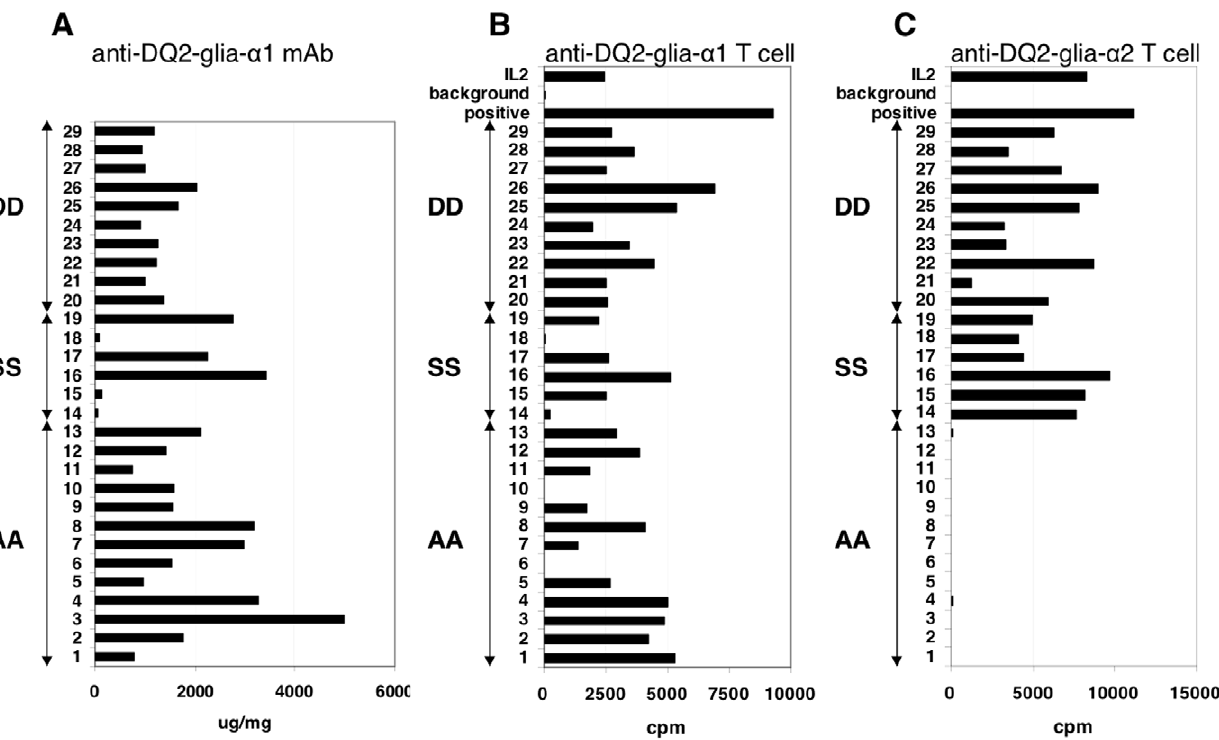
Figure 1. Presence of DQ2-Glia- a 1 and DQ2-Glia- a 2 epitopes in diploid wheat. Pepsin-trypsin digests of 29 diploid wheat accessions were prepared and tested in a competition ELISA with a mAb specific for a sequence partially overlapping with the DQ2-Glia- a 1 and DQ2-Glia- a 2 epitopes and after deamidation with T cell clones specific for the DQ2-Glia- a 1 and DQ2-Glia- a 2 epitopes. A: results of the competiton ELISA. B: T cell proliferation assay with a DQ2-Glia- a 1 specific T cell clone. C: T cell proliferation assay with a DQ2-Glia- a 2 specific T cell clone. IL-2: proliferation of the T cell clone under the influence of interleukin-2. Background: proliferation of the T cells in the presence of antigen presenting cells but no antigen. Positive control: proliferation of the T cell clone in the presence of a synthetic peptide encoding the specific a -gliadin epitope and antigen presenting cells. cpm: counts per minute. AA: diploid accessions with an A genome; SS: diploid accessions with an S genome; DD: diploid accessions with a D genome.